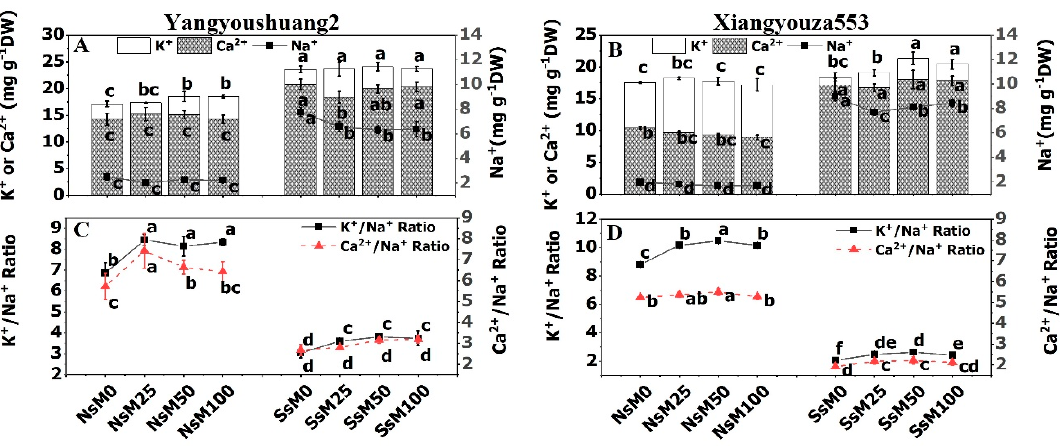
Figure 3. Response of Na + , K + , and Ca 2 + concentrations, and K + / Na + and Ca 2 + / Na + ratio in B. napus L. cultivars to seed priming with 0 µ M (M0), 25 µ M (M25), 50 µ M (M50), and 100 µ M melatonin (M100) under non-NaCl salt stress (Ns) and NaCl salt stress (Ss). ( A ) Na + , K + and Ca 2 + concentrations in Yangyoushuang2; ( B ) Na + , K + and Ca 2 + concentrations in Xiangyouza553; ( C ) K + / Na + and Ca 2 + / Na + ratios in Yangyoushuang2; ( D ) K + / Na + and Ca 2 + / Na + ratio in Xiangyouza553. Bars represent SD of three replicates. Different letters indicate significant differences among the treatments ( p ≤ 0.05).